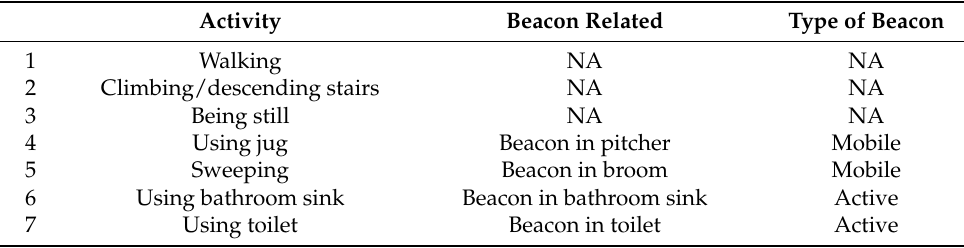
Table 2. Human activities recognized by the HAR